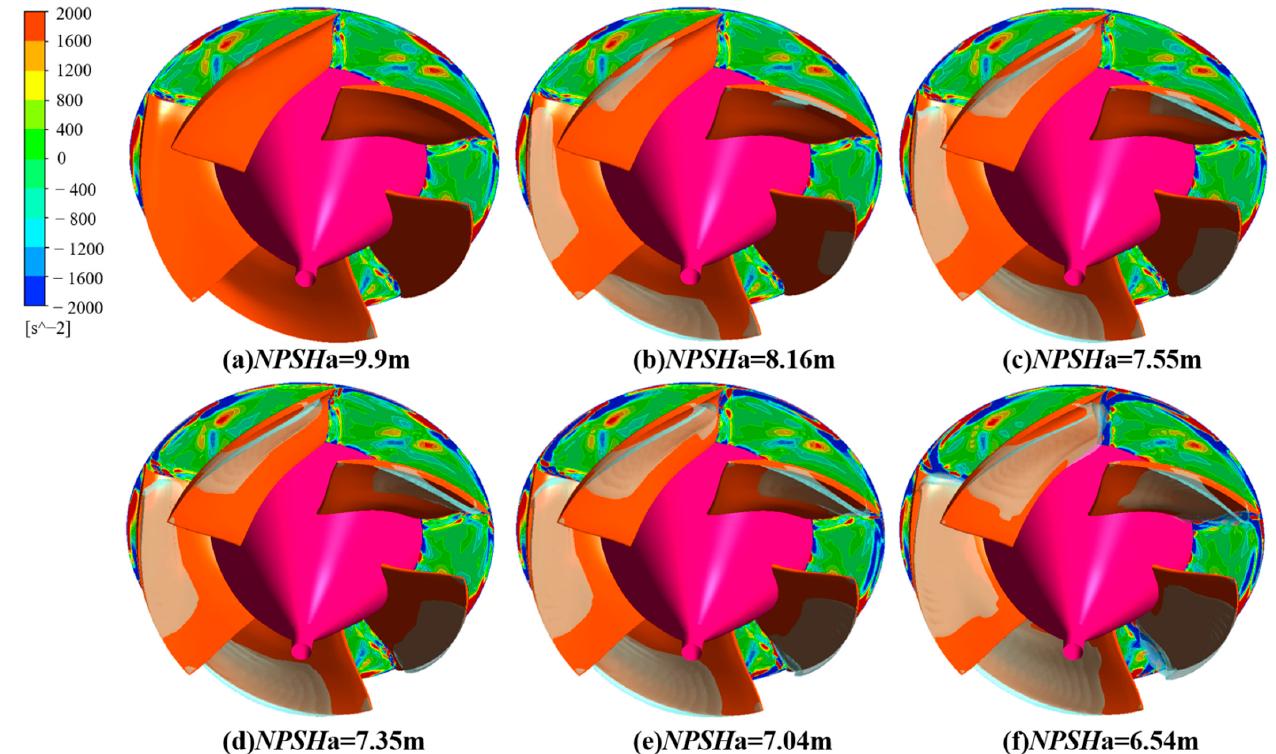
Figure 15. Cavitation region and contours of the vortex dilatation term on the spanwise section near TE.